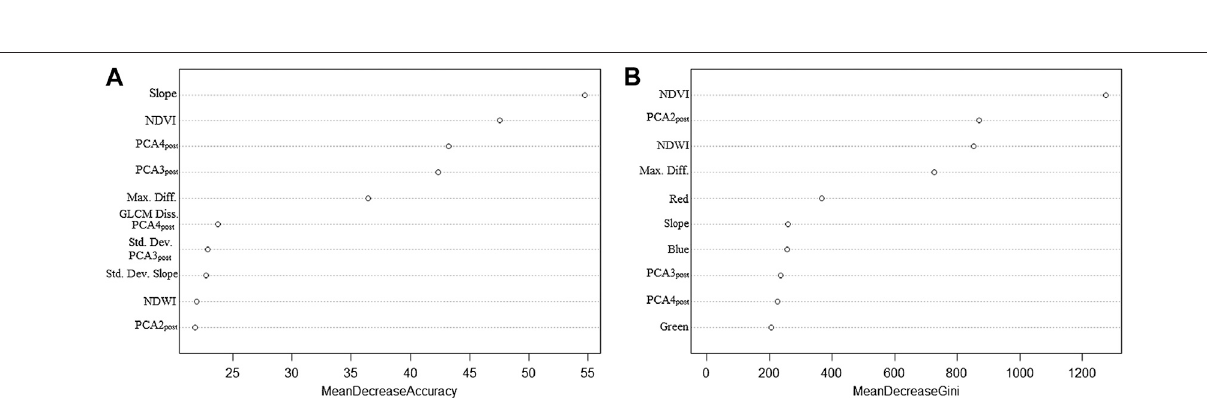
Frontiers in Earth Science |